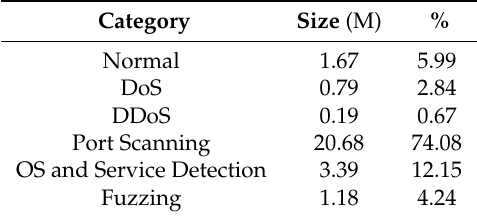
Table 3. Distribution of records in the first SDN